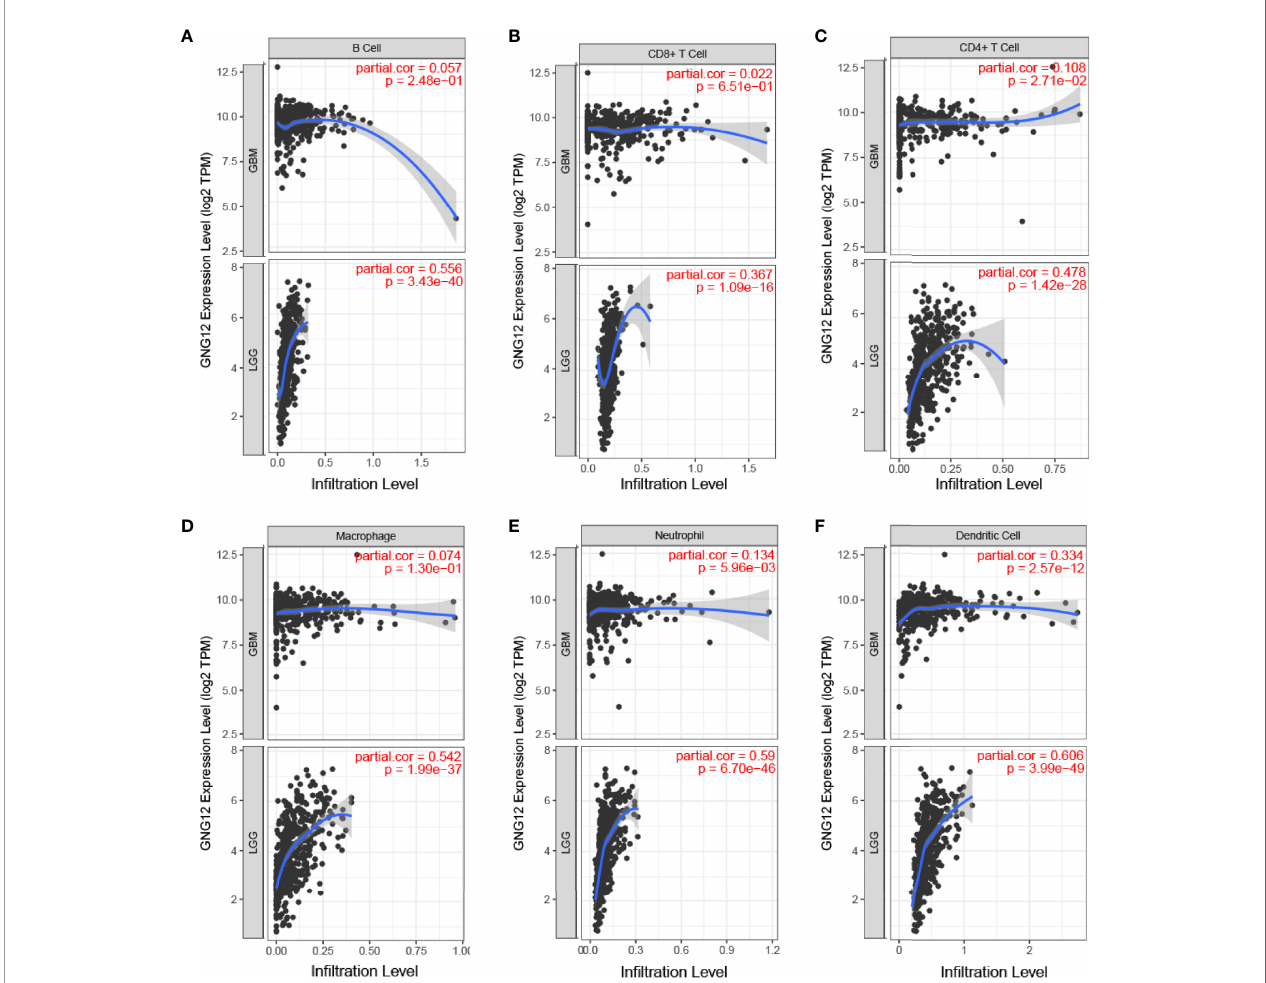
FIGURE 4 | Relationship between expression of the GNG12 gene and proportion of immune in fi ltrates. (A) B Cell (B) CD8+T Cell (C) CD4+T Cell (D) Macrophage (E) Neutrophil (F) Dendritic